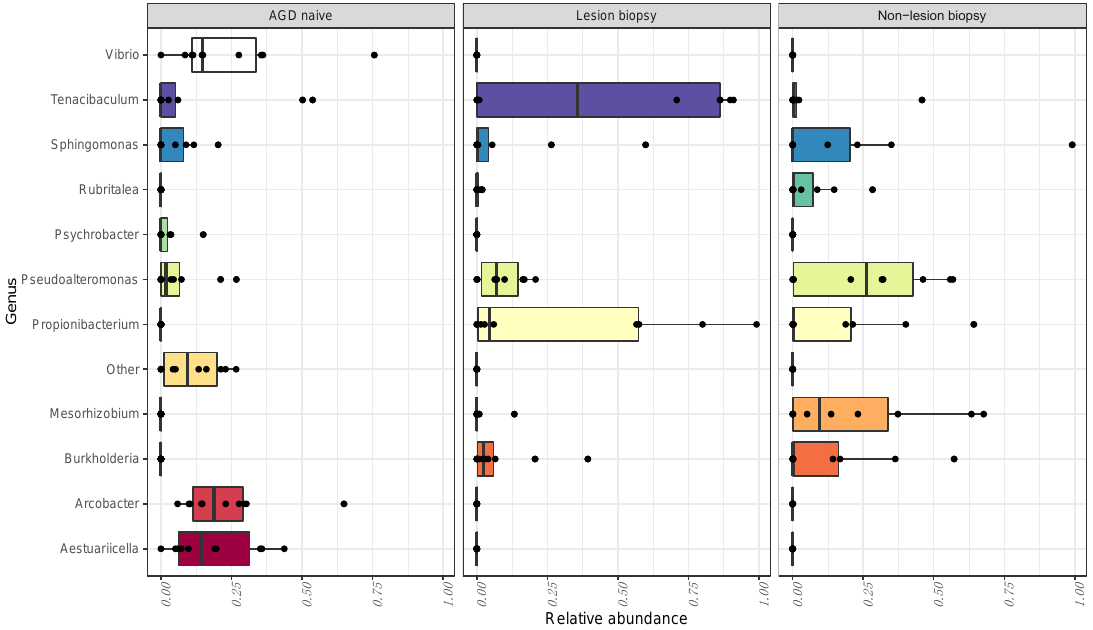
Figure 6. Top 11 genus differentially expressed between naïve, LB and NLB groups (DESeq2). The differential analysis was compared between all groups, with an adjusted p value of ( p < 0.001). Data shows that the taxa Propionibacterium and Tenacibaculum have a significantly stronger association to AGD lesions than in other groups.